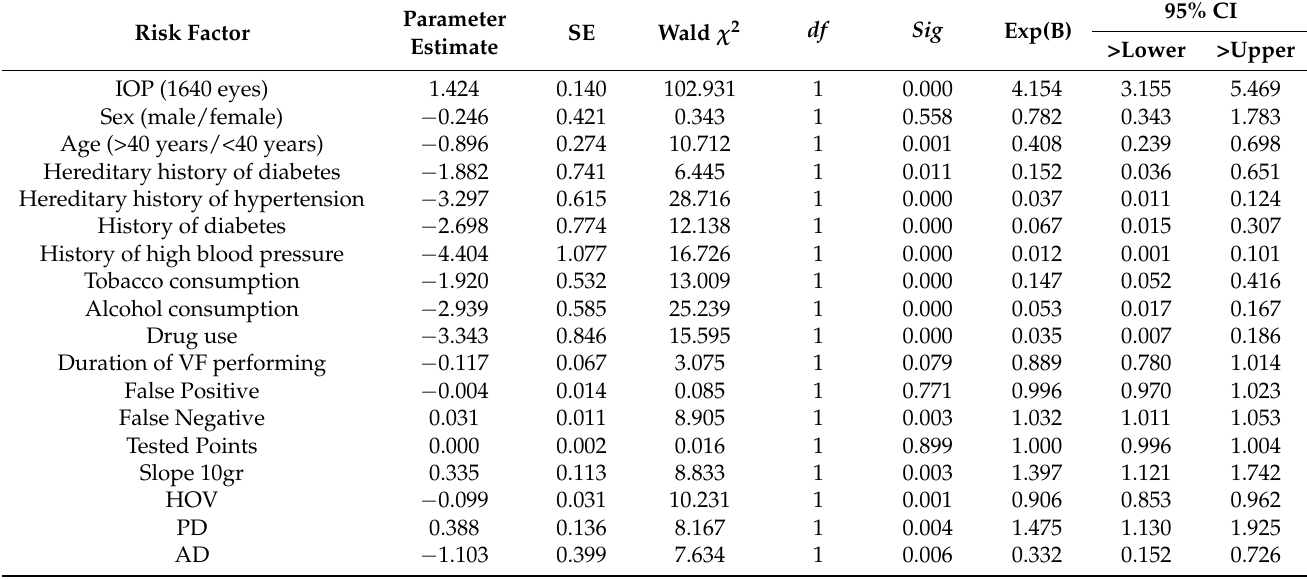
Table 8. Distribution of binomial logistic analysis results for OHT suspect variables at the screening test.